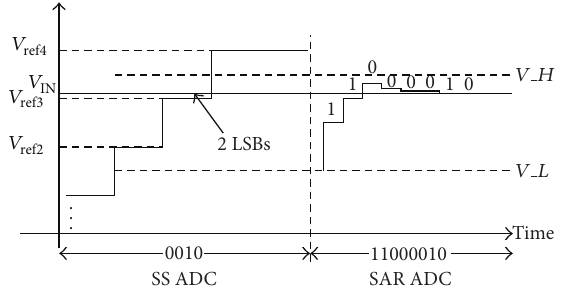
Figure 4: The operating principal of the proposed ADC with quantization noise.